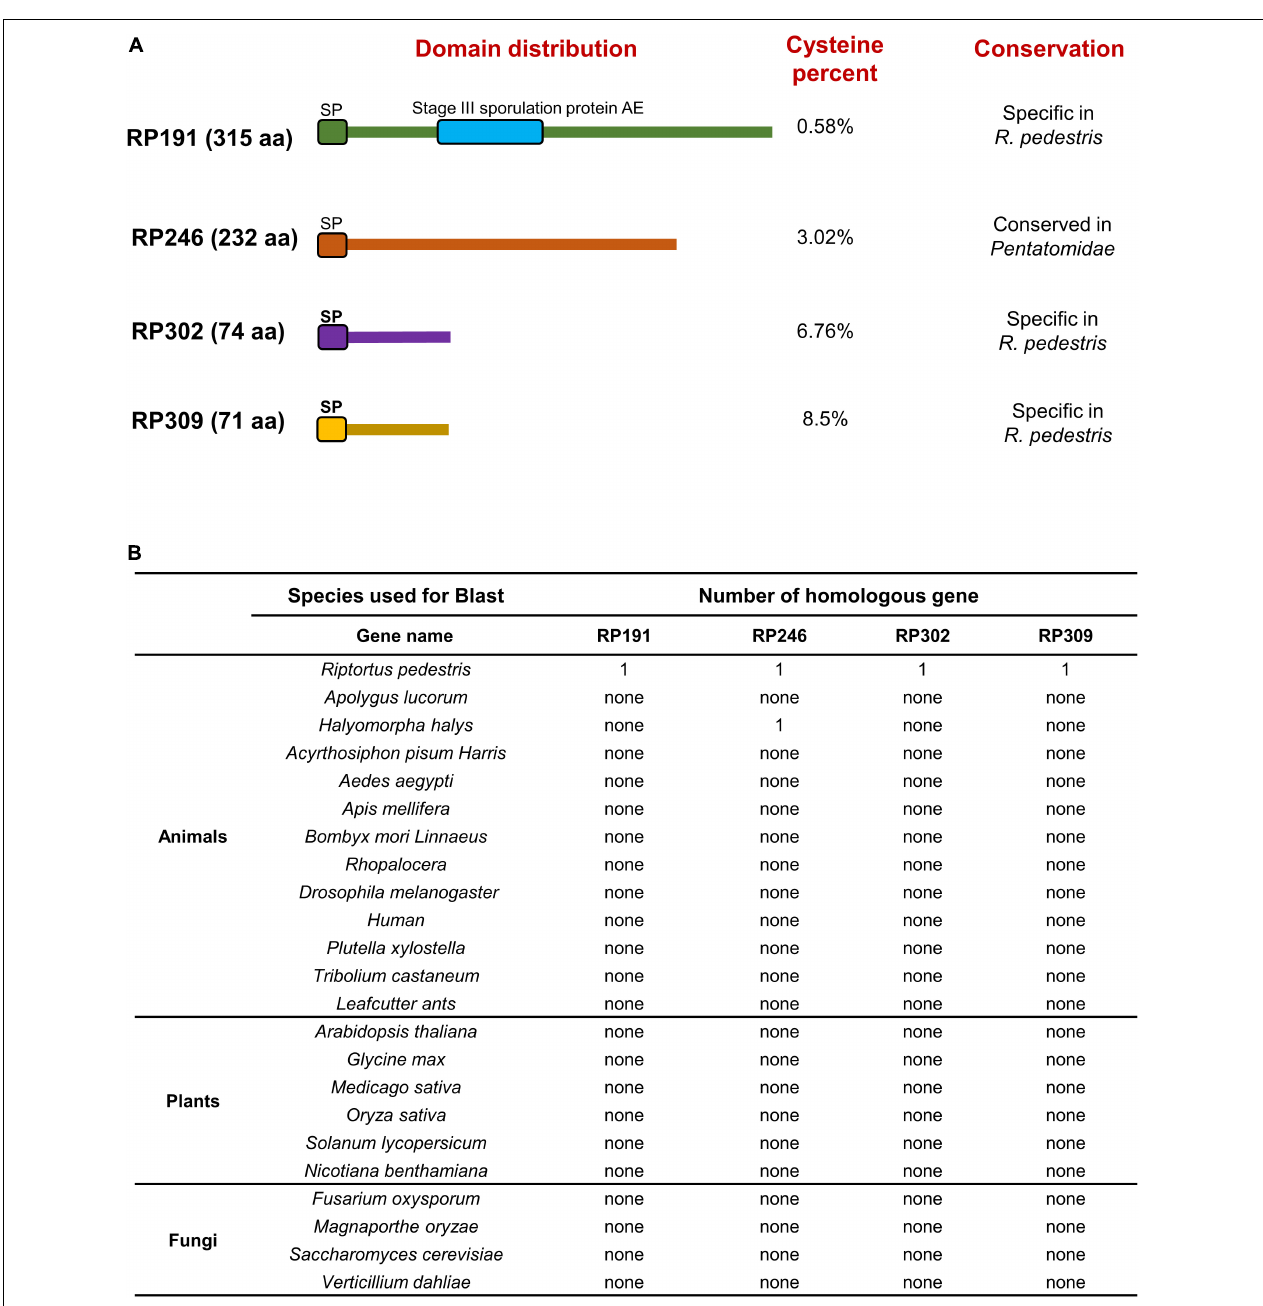
FIGURE 8 | Functional domain prediction and analysis of homologous genes in other organisms. (A) Functional domain prediction of necrosis inducing proteins (NIPs). SP, signal peptide. (B) Homologous gene analysis of four NIPs using the Blast algorithm (NCBI) against other reported sequences.